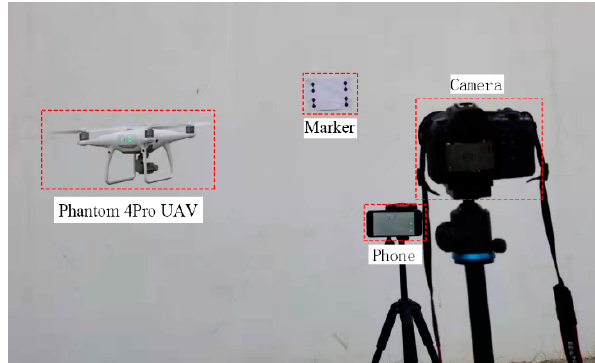
Figure 1. UAV hovering monitoring lens noise test equipment.